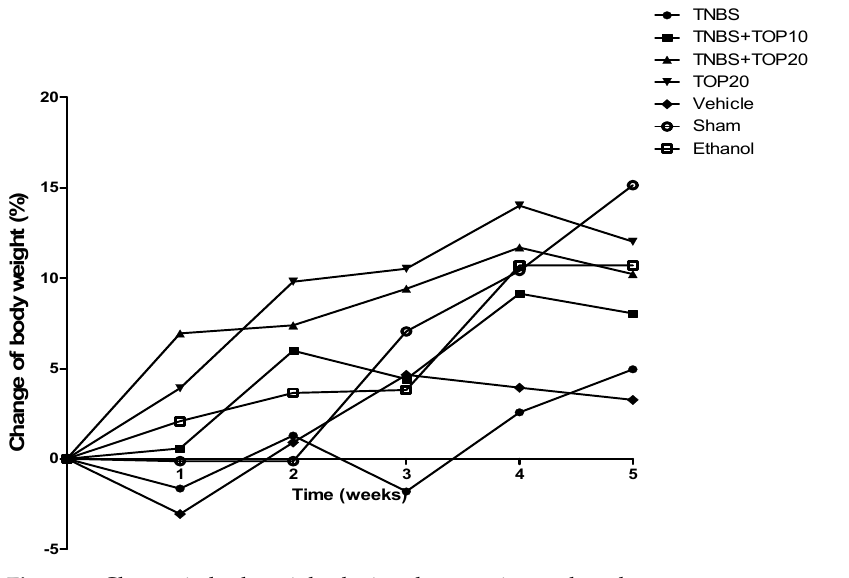
Figure 1. Change in bodyweight during the experimental study.